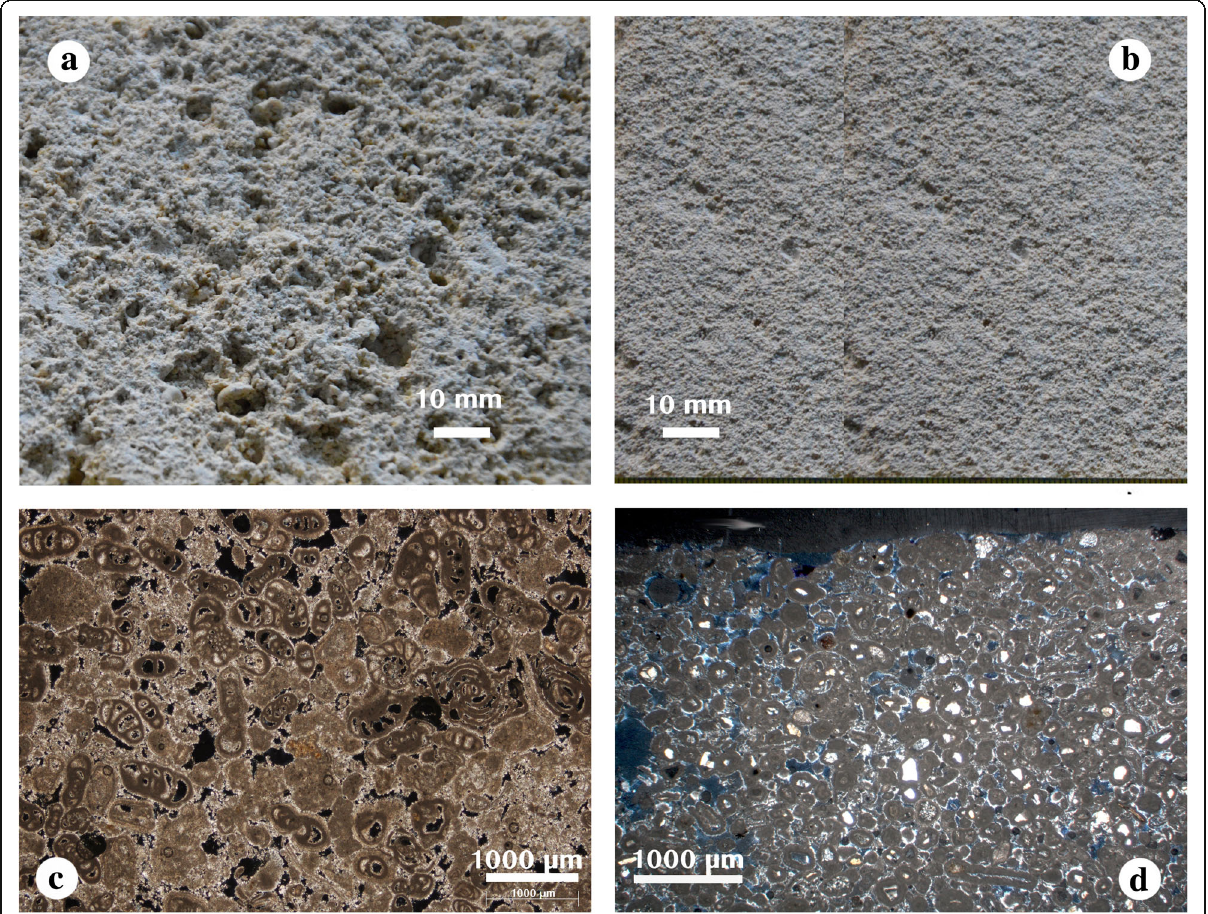
Fig. 2 Images (top) and thin section photographs (bottom) of porous limestones: coarse-grained limestone ( a , c ) and fine-grained limestone ( b , d